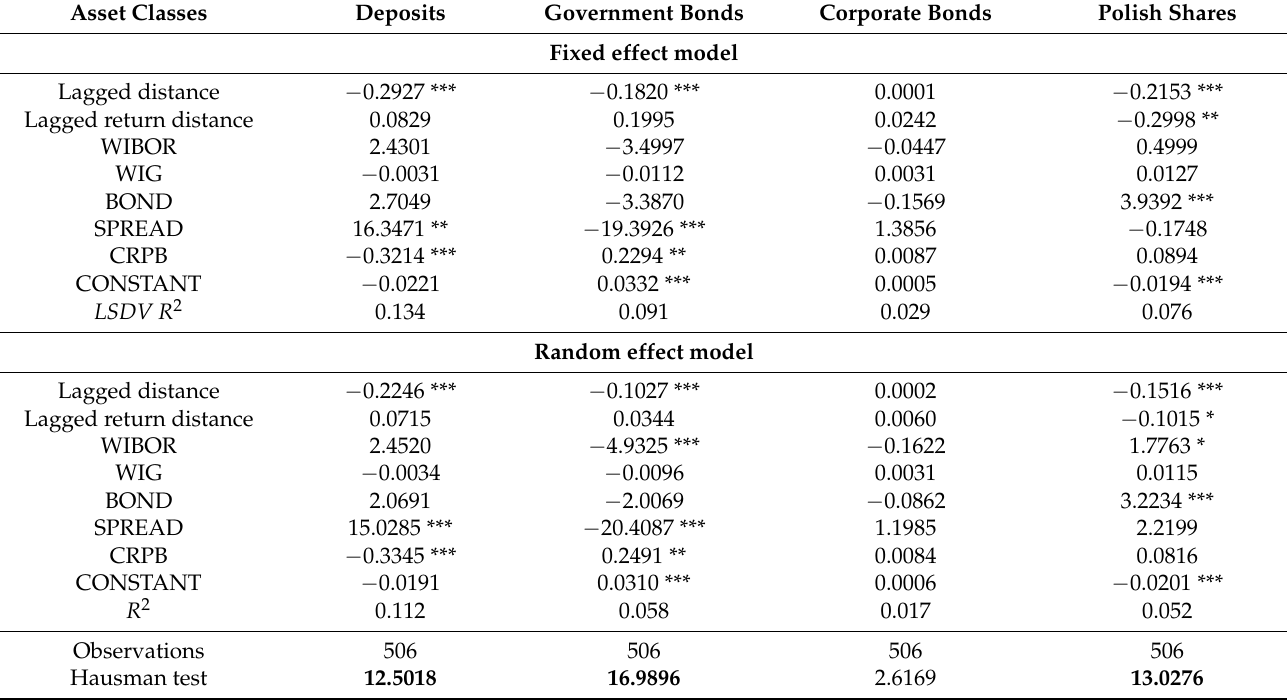
Table 3. Determinants of change in OPF asset allocations,